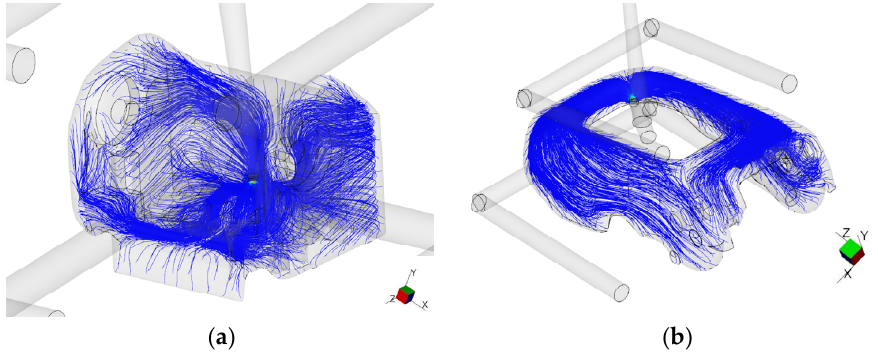
Figure 7. Path-line of pivot sub-assembly and open lever existing in mass production. ( a ) Pivot sub-assembly. ( b ) Open